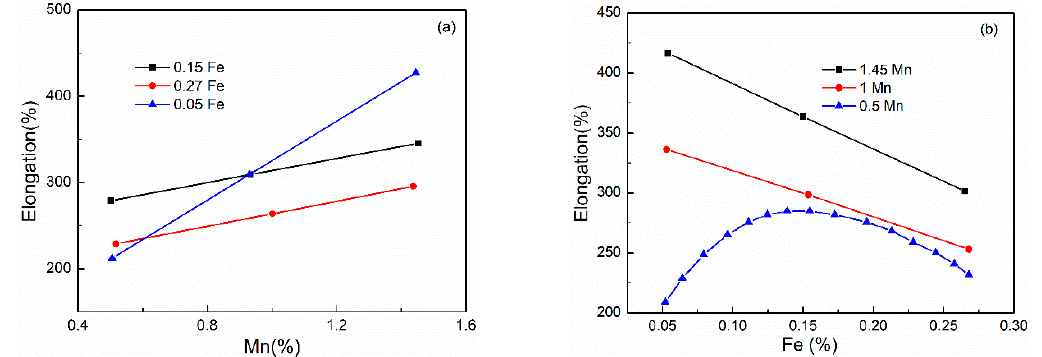
Figure 11. Total elongation vs. ( a ) Mn and ( b ) Fe content [127].